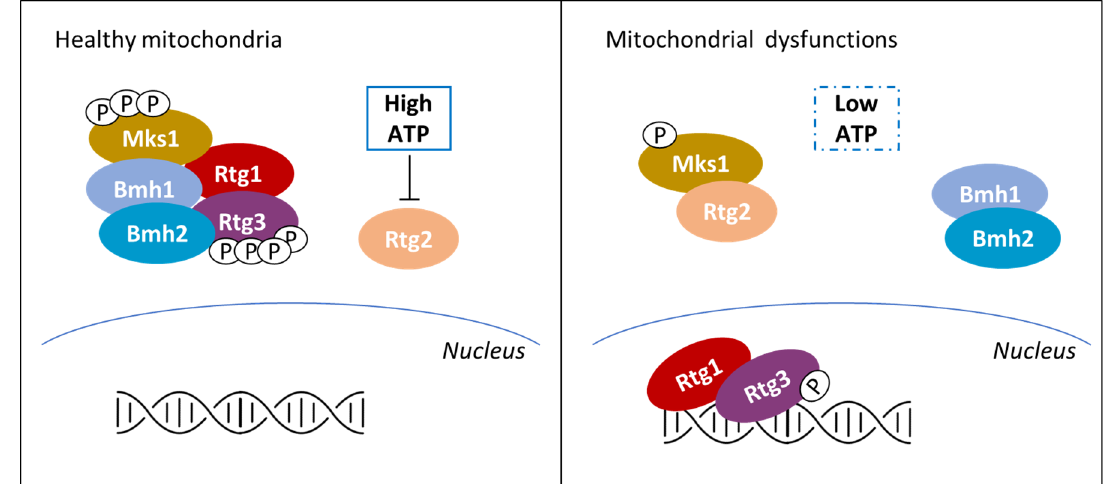
Figure 4. Regulation of the mitochondrial retrograde response in S. cerevisiae . In yeast cells presenting healthy mitochondria, Rtg1-Rtg3 complex is recruited to the cytosol by the Mks1-Bmh1 / 2 complex, with both Rtg3 and Mks1 hyper-phosphorylated. The interaction between Rgt2 and Mks1 is inhibited by ATP interaction with Rtg2 or with other components of the complex. Mitochondrial dysfunction causes a drop in ATP concentration (indicated by the dotted box), leading to Rtg2-Mks1 interaction and hypo-phosphorylated Rtg3 and Mks1. As a consequence, the nuclear localization of the Rtg1-Rtg3 complex induces the expression of RTG genes.